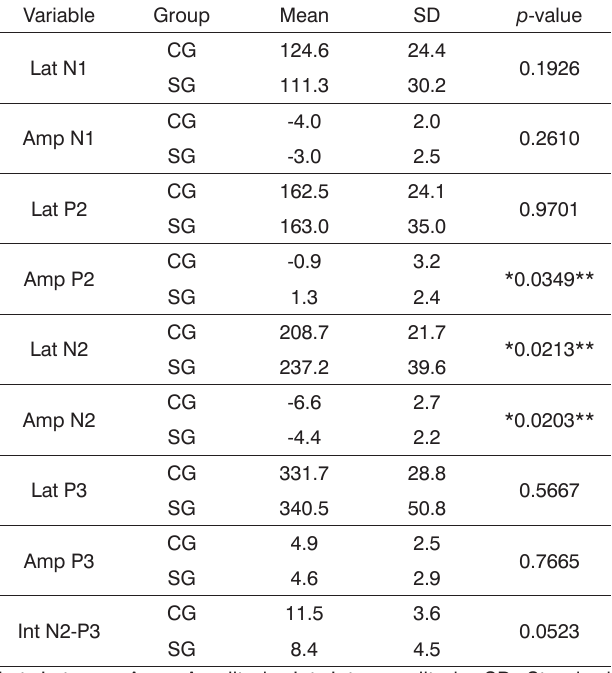
Table 2. Descriptive statistics of the mean, standard deviation (SD) and p -value of the N1, P2, N2, P3 latency and amplitude variables and P300f N2-P3 inter-amplitude for the